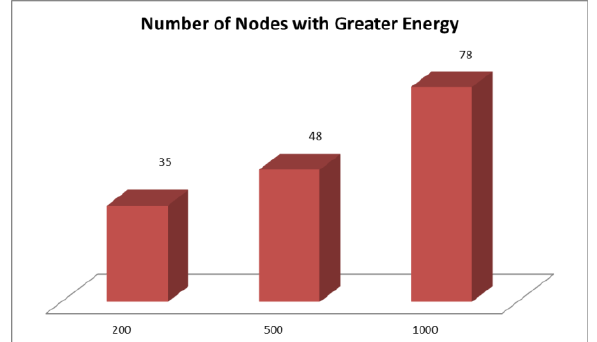
Figure 6. Sensors with greater energy.